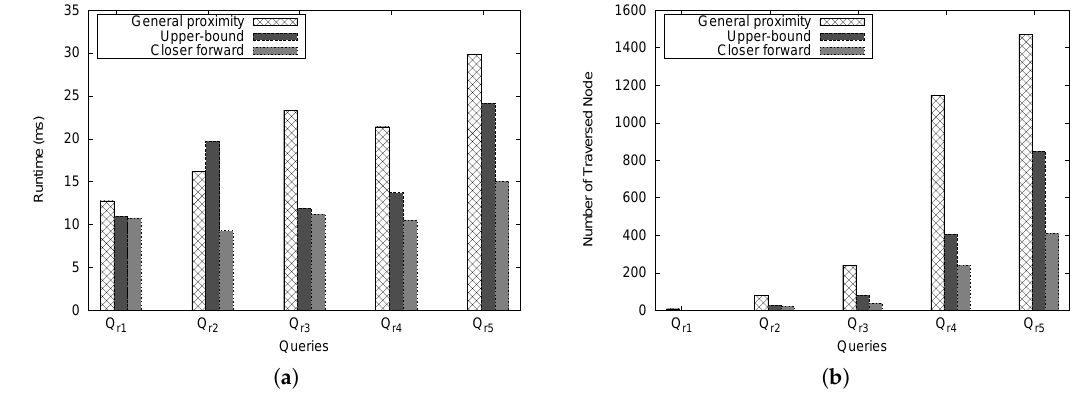
Figure 21. River-separated case. ( a ) execution time; ( b ) number of traversed nodes.